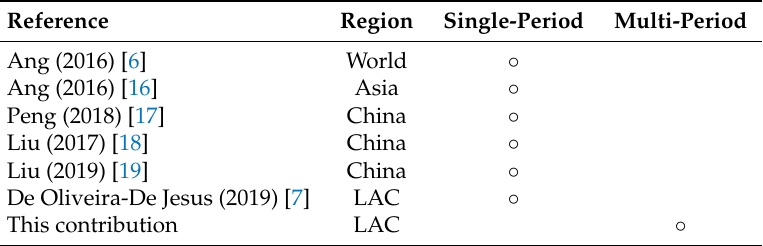
Table 1. Contributions on carbon emission Logarithmic Mean Divisia for Index Decomposition Analysis (IDA-LMDI)